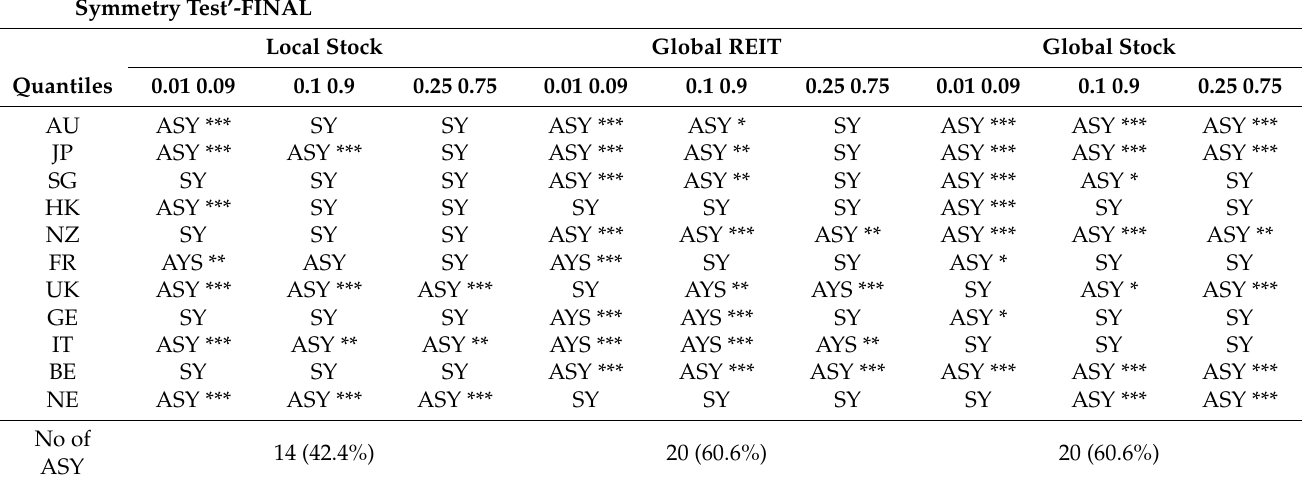
Table 4. Summary results for symmetric quantiles